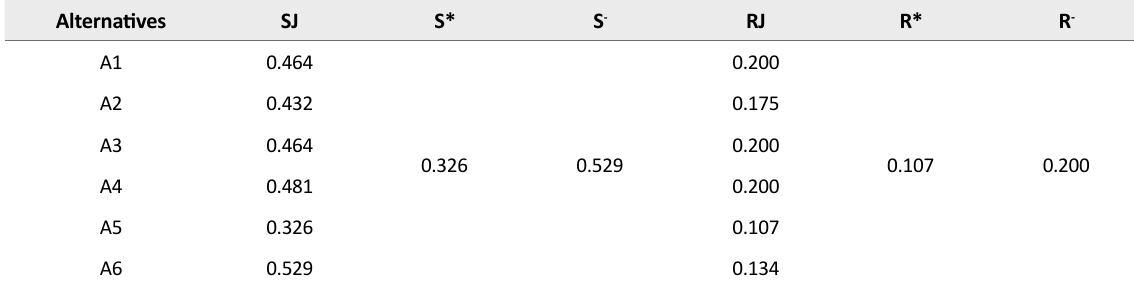
Table 4. The values of Ri & Si and maximum and minimum values of Si and Ri Alternatives